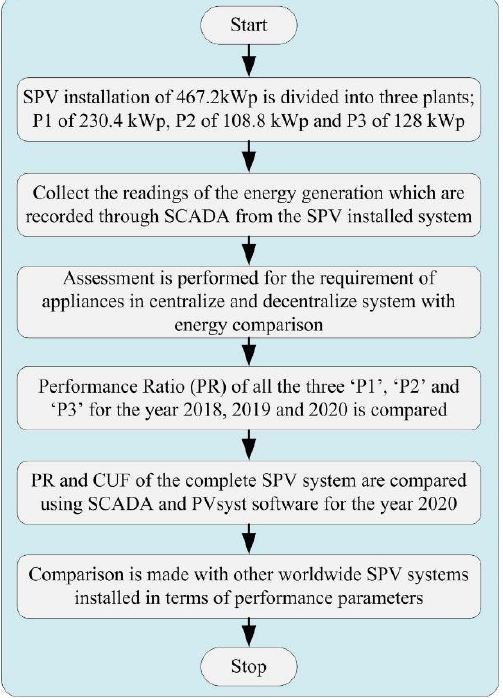
Figure 1. Methodology followed for assessment and comparison of SPV plant.